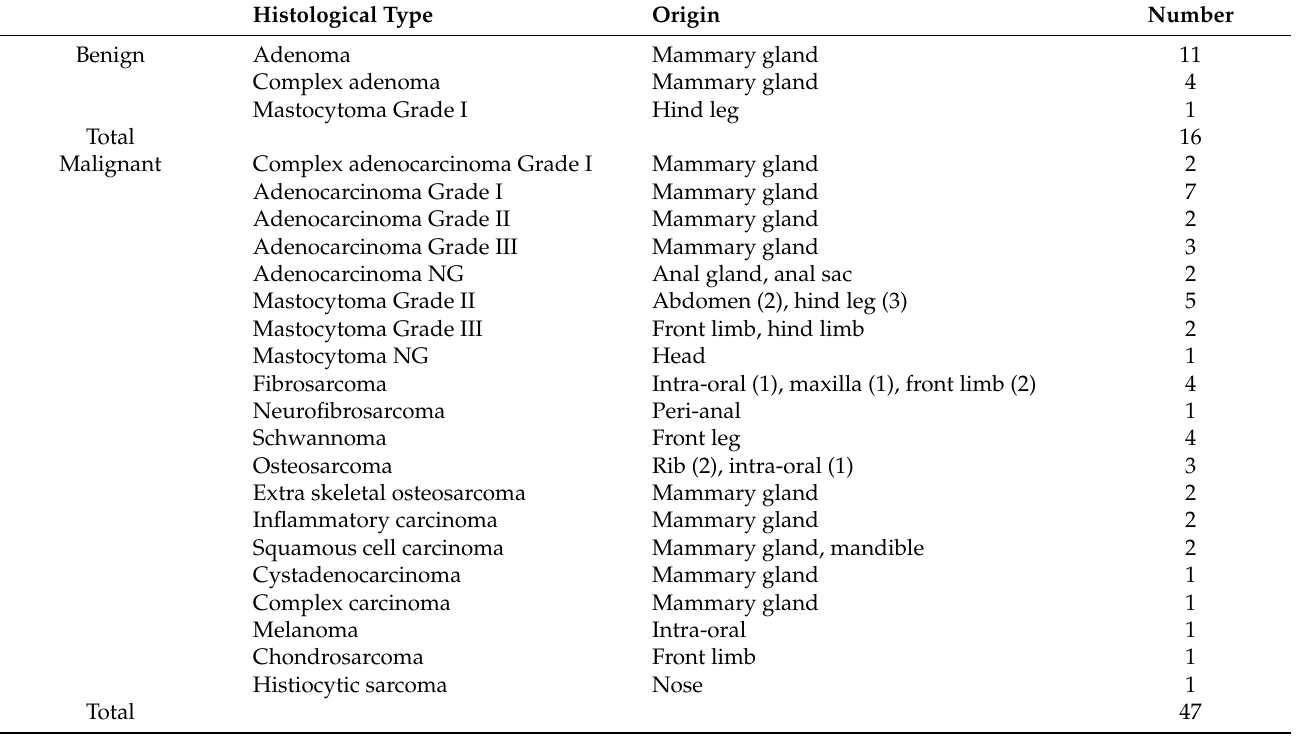
Table 1. Histologic types of the benign and malignant superficial neoplasms evaluated in dogs. Histological Type